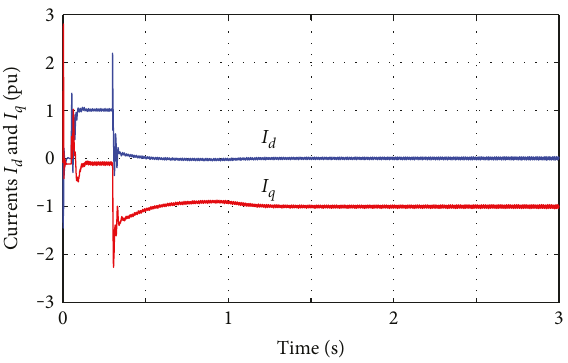
I d and q during LVRT.